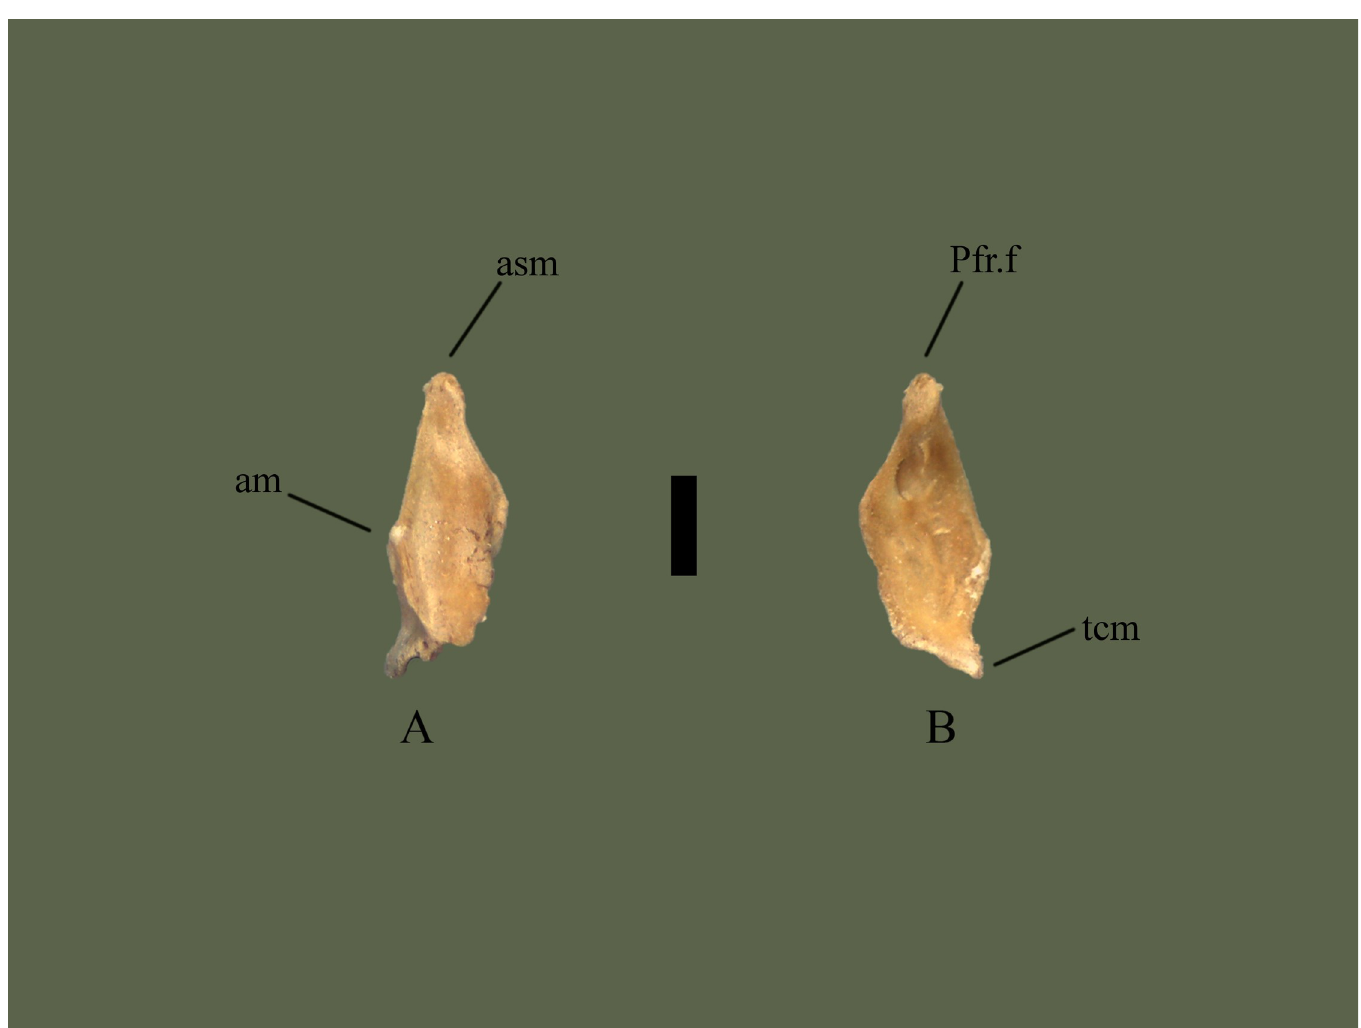
Fig 10. Right maxilla (ETVP 3306) in anterior (A) and posterior (B). Scale bar = 1mm. Abbreviations: Pfr.f = prefrontal facet; am = anterior process of maxilla; asm = ascending process of maxilla; tcm = transverse crest of